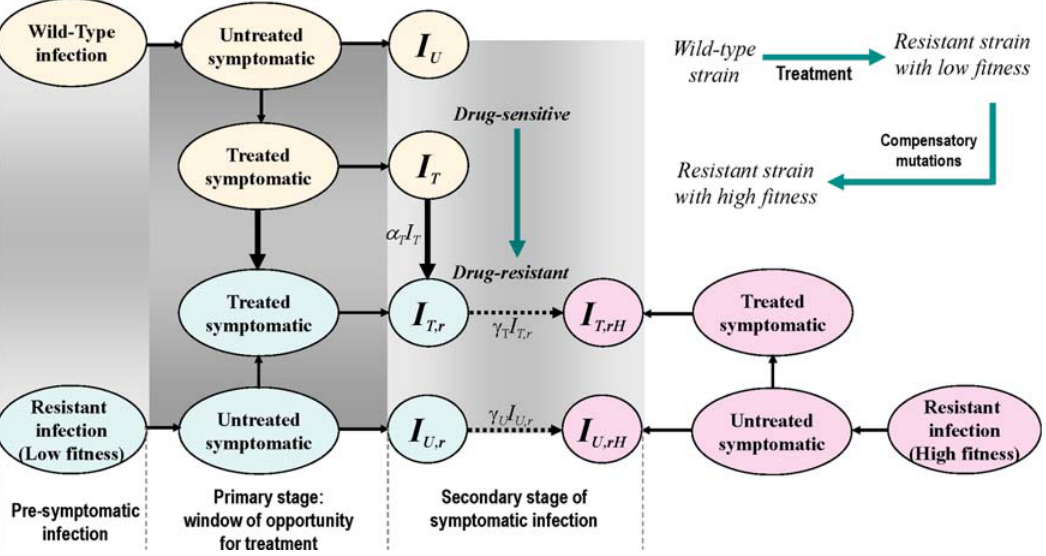
Figure 1. Model structure for the emergence of drug-resistance during treatment of symptomatic infections. The clinical course of disease is divided into three stages: pre-symptomatic; primary; and secondary stages of symptomatic infections. Drug-resistance with low transmission fitness can emerge during treatment of individuals infected with the wild-type virus. It is assumed that compensatory mutations may result in generation of resistant mutants with high transmission fitness during the secondary stage of treated symptomatic infection. The compartments of untreated and treated individuals infected with the wild-type strain are represented by I U and I T , respectively. The corresponding compartments for the resistant strain with low (high) transmission fitness are denoted by sub-index r ( rH ).